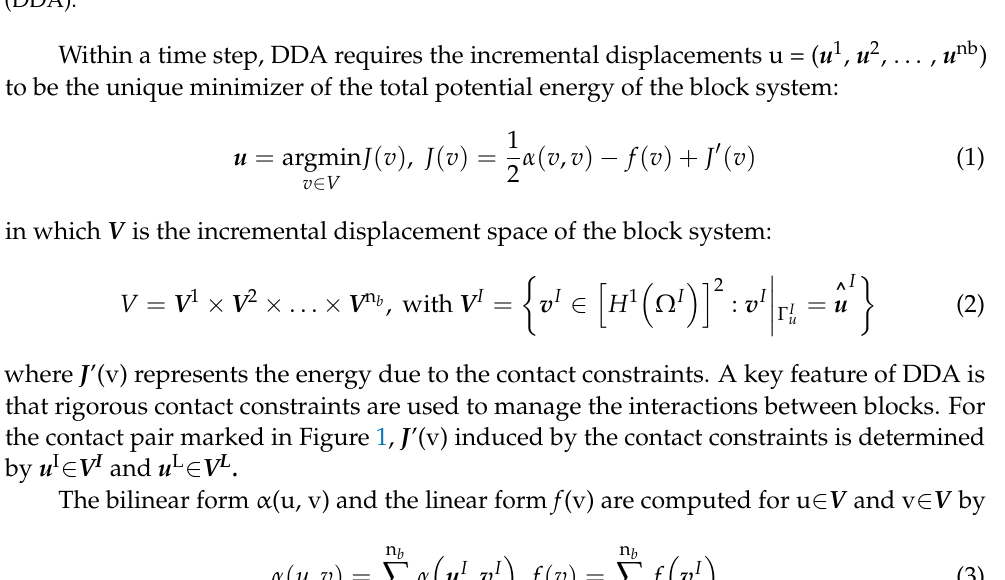
Figure 1. A typical block system and an individual block in Discontinuous Deformation Analysis (DDA).